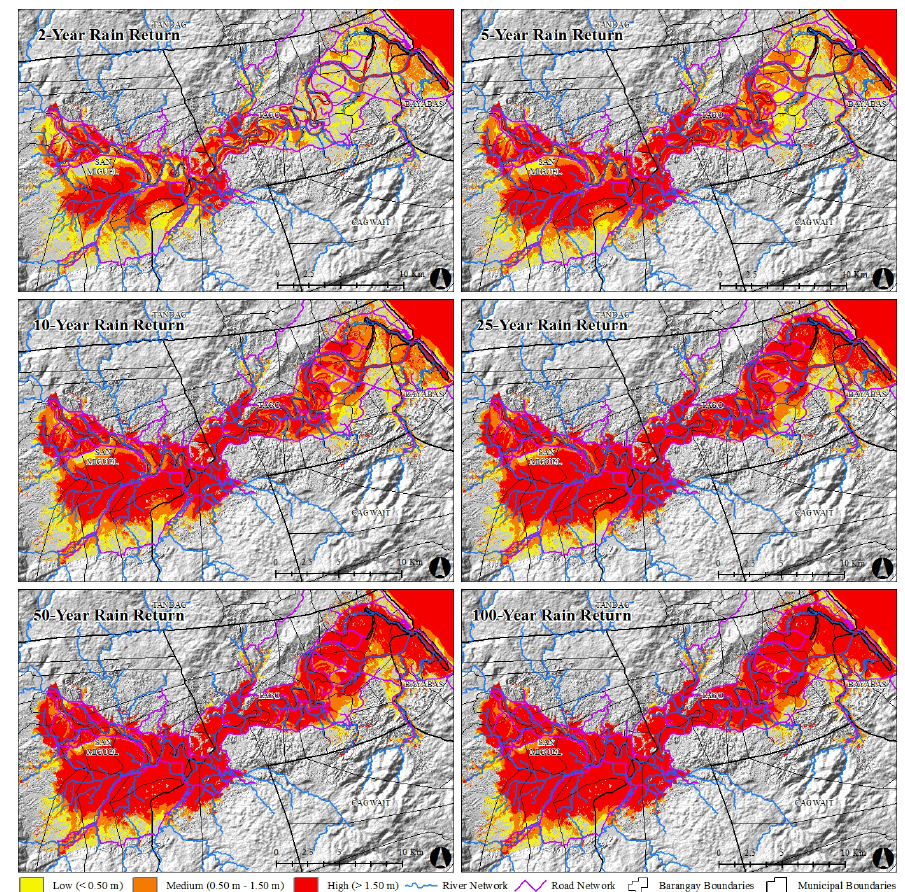
Figure 7: The generated flood hazard maps of Tago River Basin for the 6 rainfall return periods.